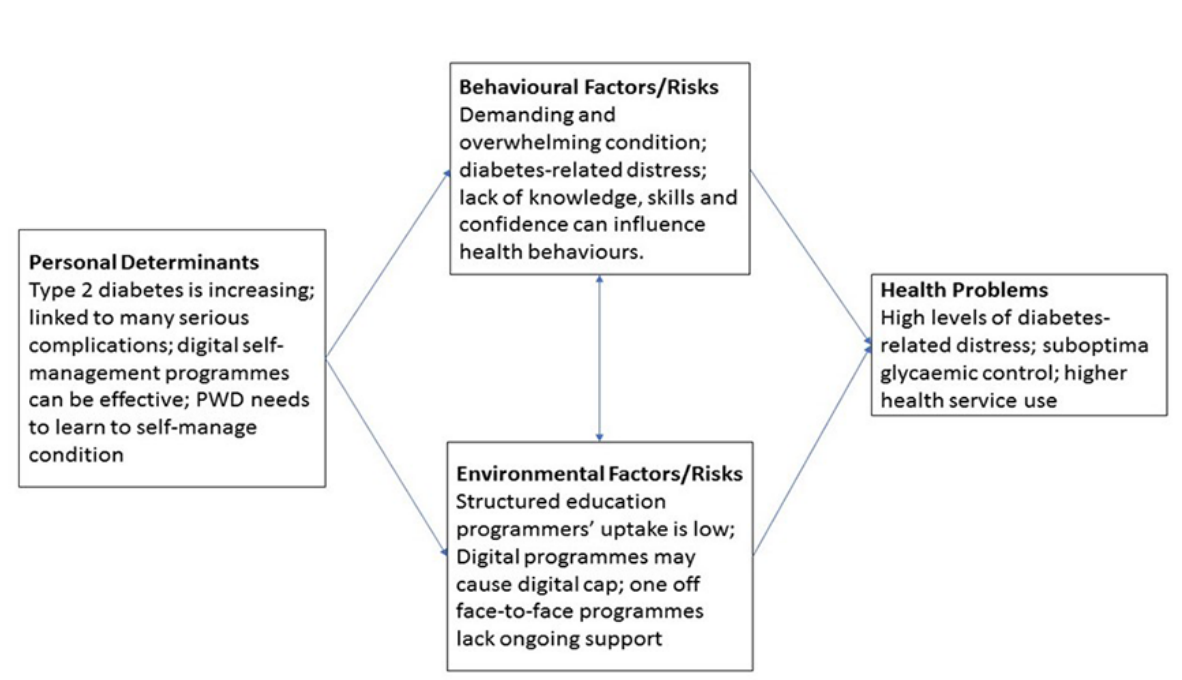
Figure 2. Logic model of the problem, step 1